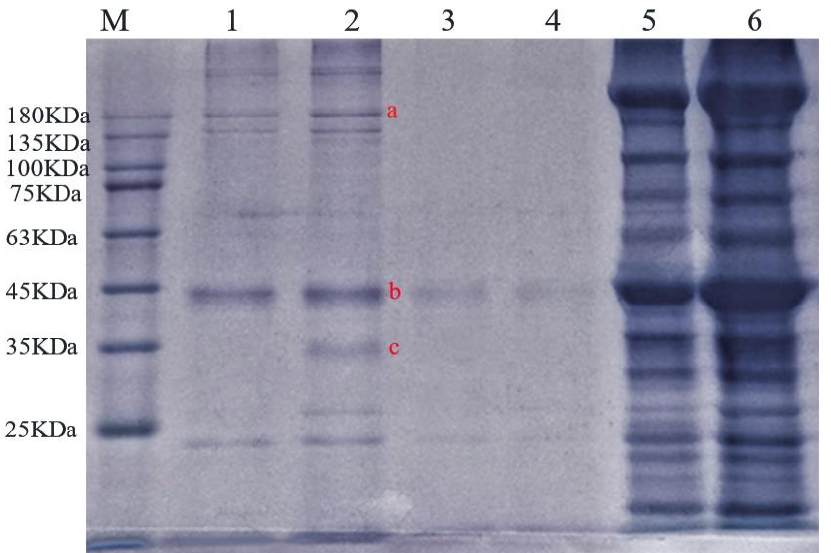
Figure 4. Effect of ST on the protein composition of beef: 1, 2 swimming lanes are ST beef and boiled beef water-soluble protein; 3, 4 swimming lanes are ST beef and boiled beef salt-soluble protein; 5, 6 swimming lanes are ST beef and boiled beef insoluble protein. Different letters denote different proteins.